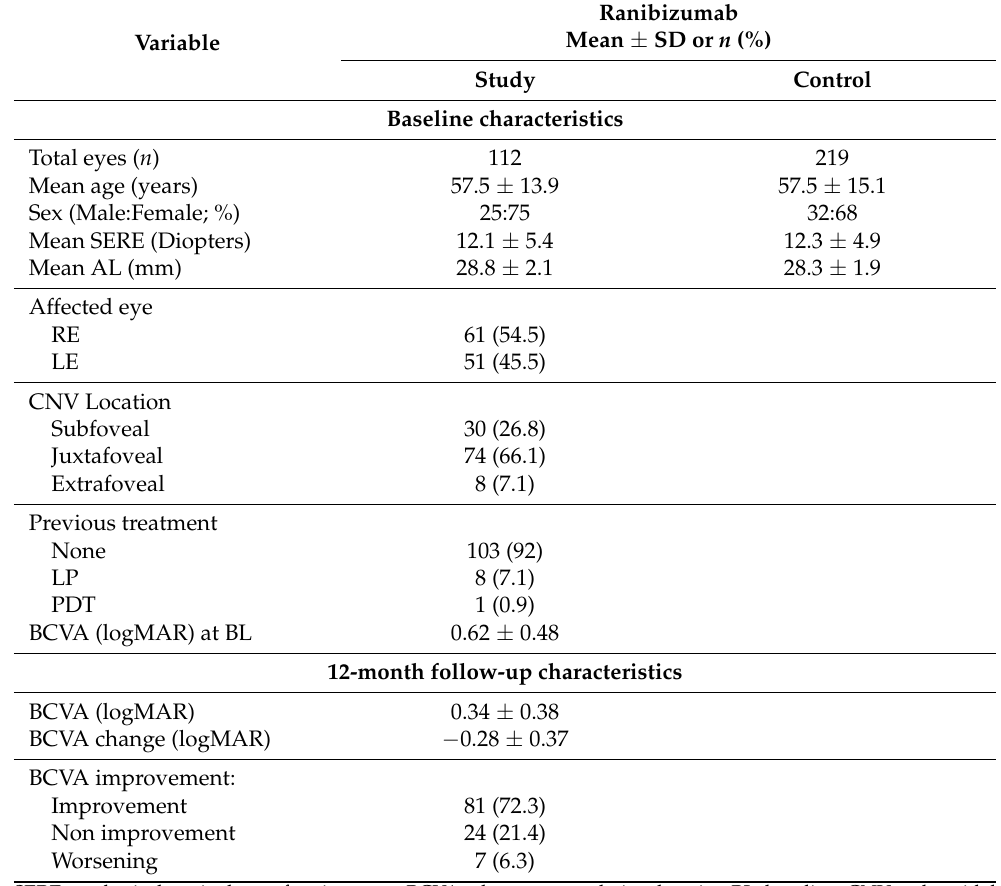
Table 1. Baseline and follow-up descriptive